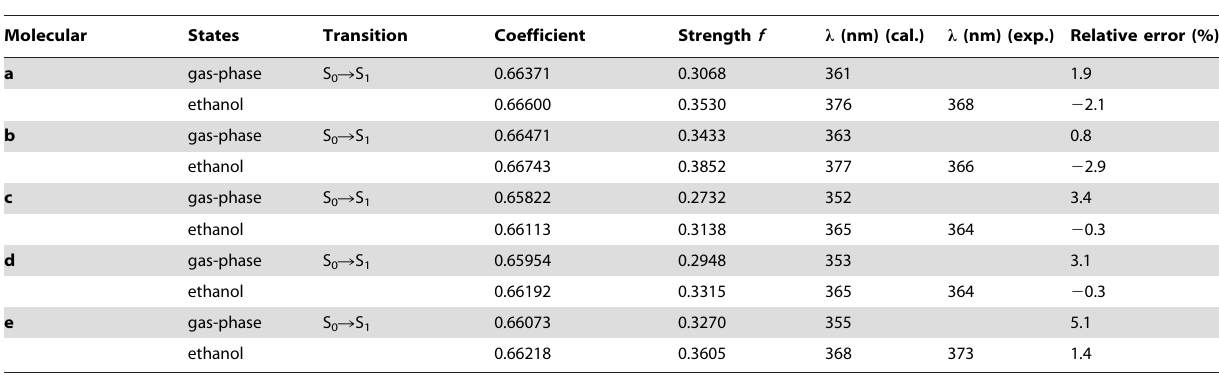
Table 7. Calculated absorption spectra of a–e in vacuum and in ethanol.